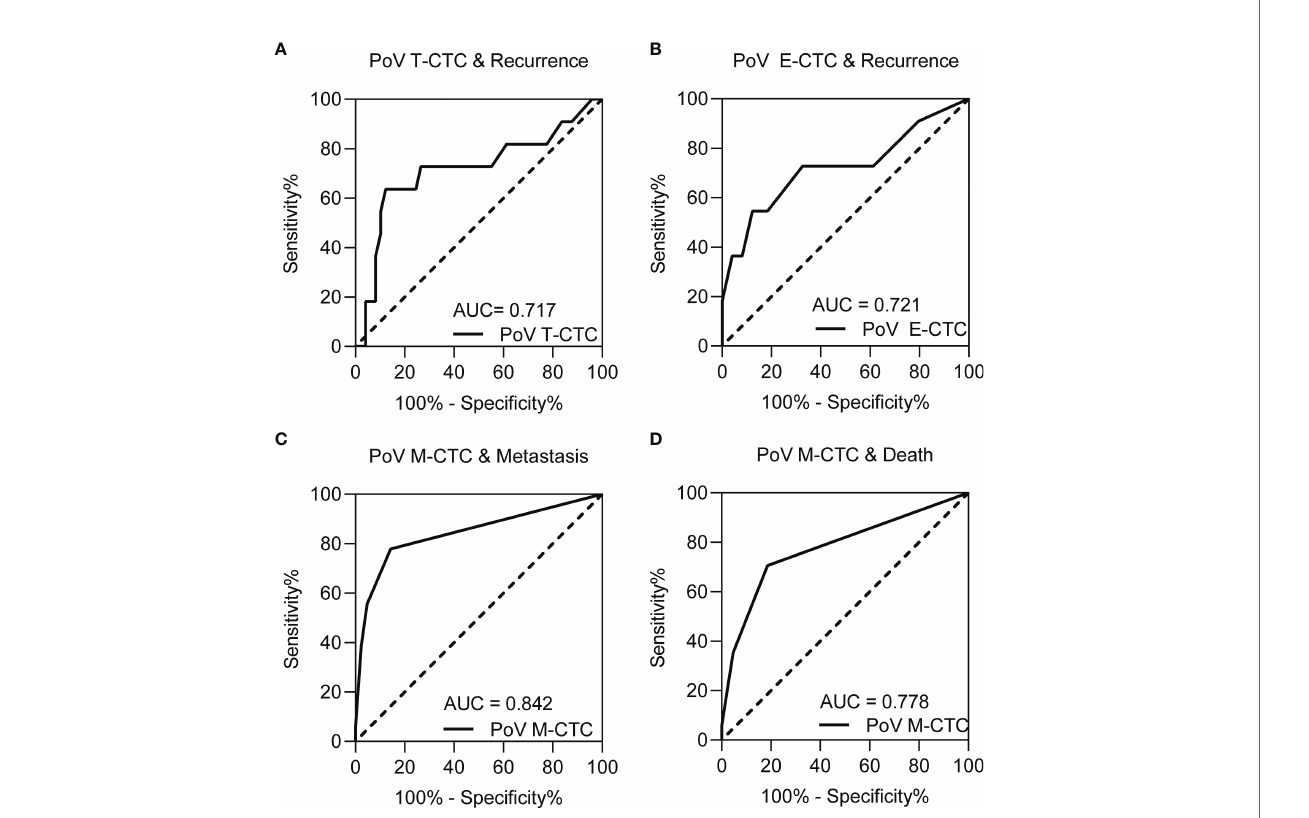
FIGURE 4 | The ROC curve for (A) PoV T-CTCs, (B) PoV E-CTCs on recurrence prediction, (C) PoV M-CTCs for metastasis prediction and (D) PoV M-CTCs for death prediction. The result of sensitivity, speci fi city and cut-off value of each ROC curve are depicted in Table 2 .